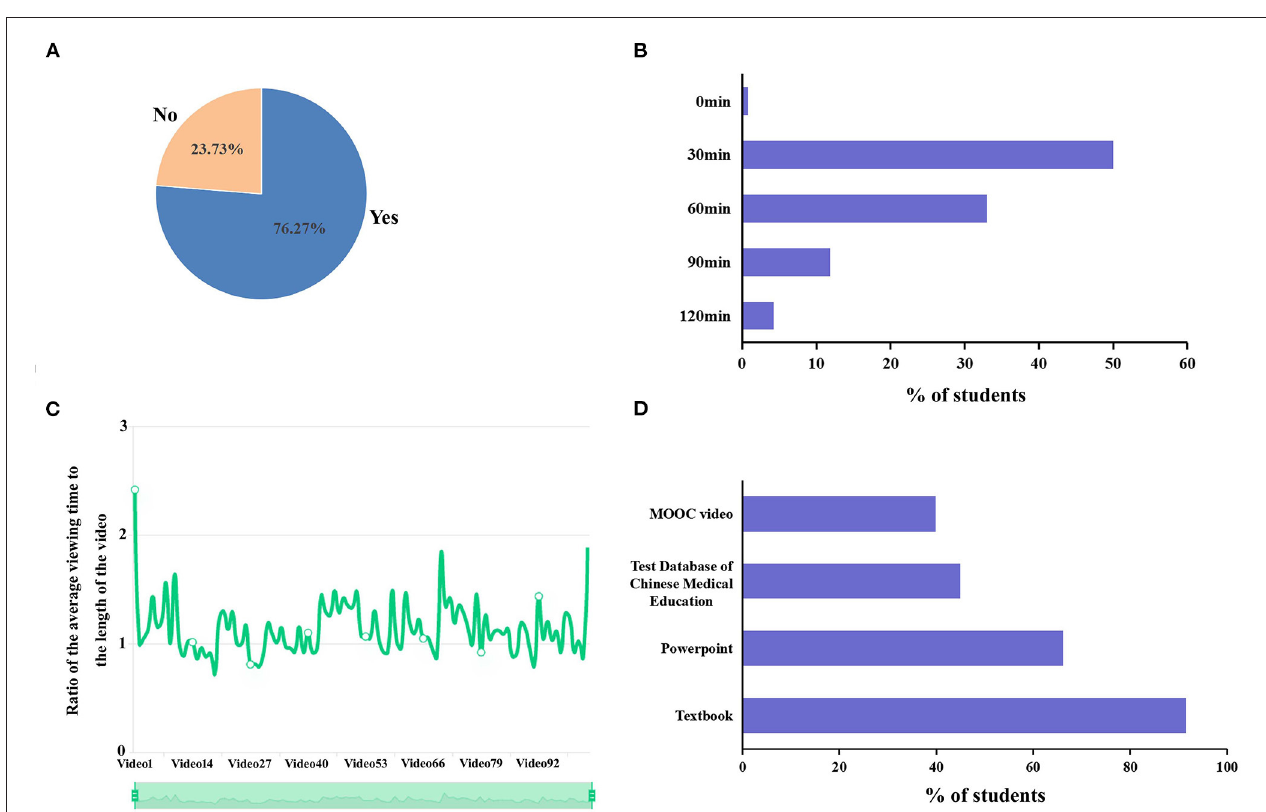
FIGURE 2 | The status of students in 2018 class in completing the pathophysiology self-study before class ( n = 118). (A) Percentages of students divided by whether they can complete the pre-view. (B) Time spent by students in pre-view. (C) Comparison of video viewing duration and video length (automatically generated by Chinese Universities MOOC platform). (D) Percentages of students who preferred different learning materials to complete the pre-learning.